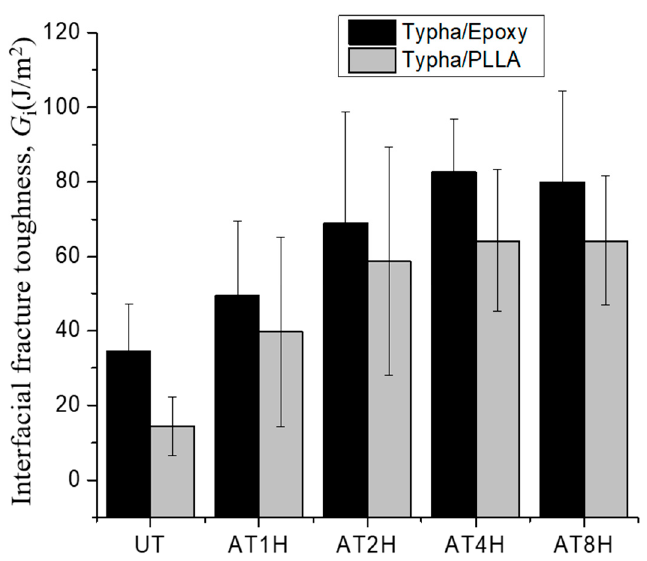
Figure 10. The comparison of the mean interfacial fracture toughness Typha spp. fiber/PLLA and Typha spp. fiber/Epoxy.